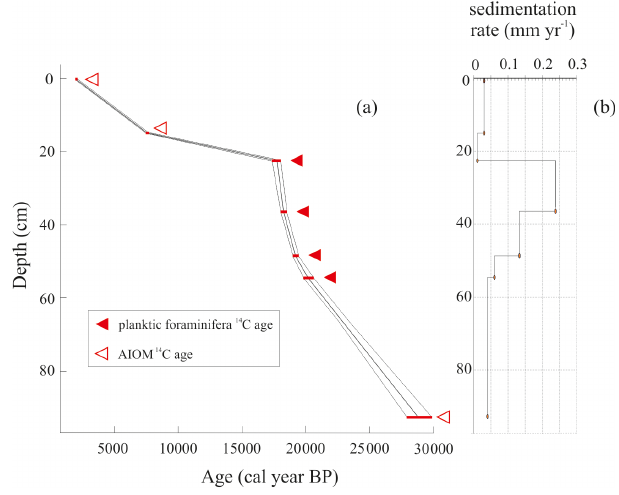
Figure 2. (a) Age–depth model based on the linear interpolation of best point calibration ages from AMS 14 C dates obtained using Clam software (Blaauw, 2010). The dotted lines show the 95% con- fidence intervals based on 1000 iterations. (b) Sedimentation rate in millimeters per